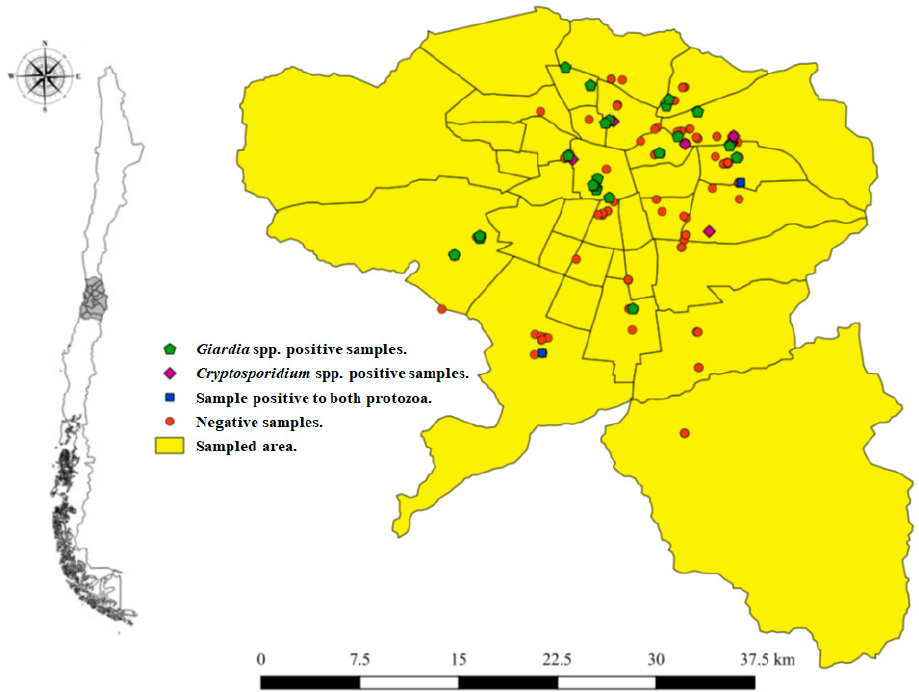
Figure 1. Sampled area within the city of Santiago, Chile. Green pentagons represent Giardia spp. positive samples; purple rhombus represents Cryptosporidium spp. positive samples; blue squares represent samples that were positive to both parasites; red dots represent negative samples.